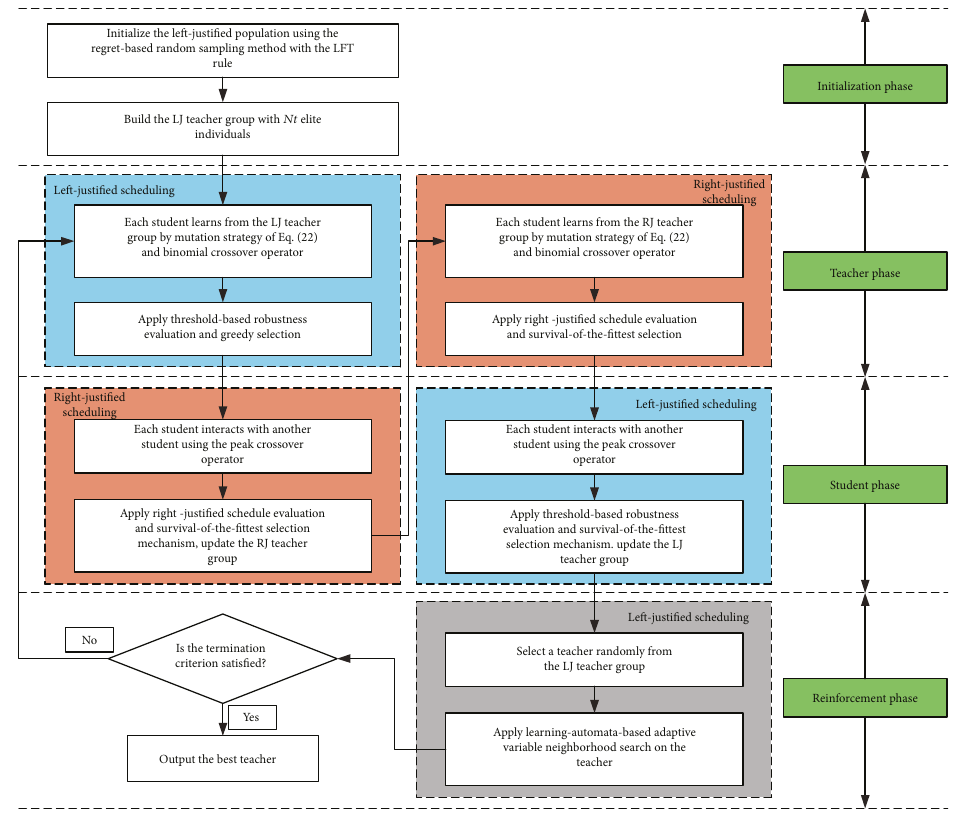
Figure 6: The fl owchart of HTLBO for the